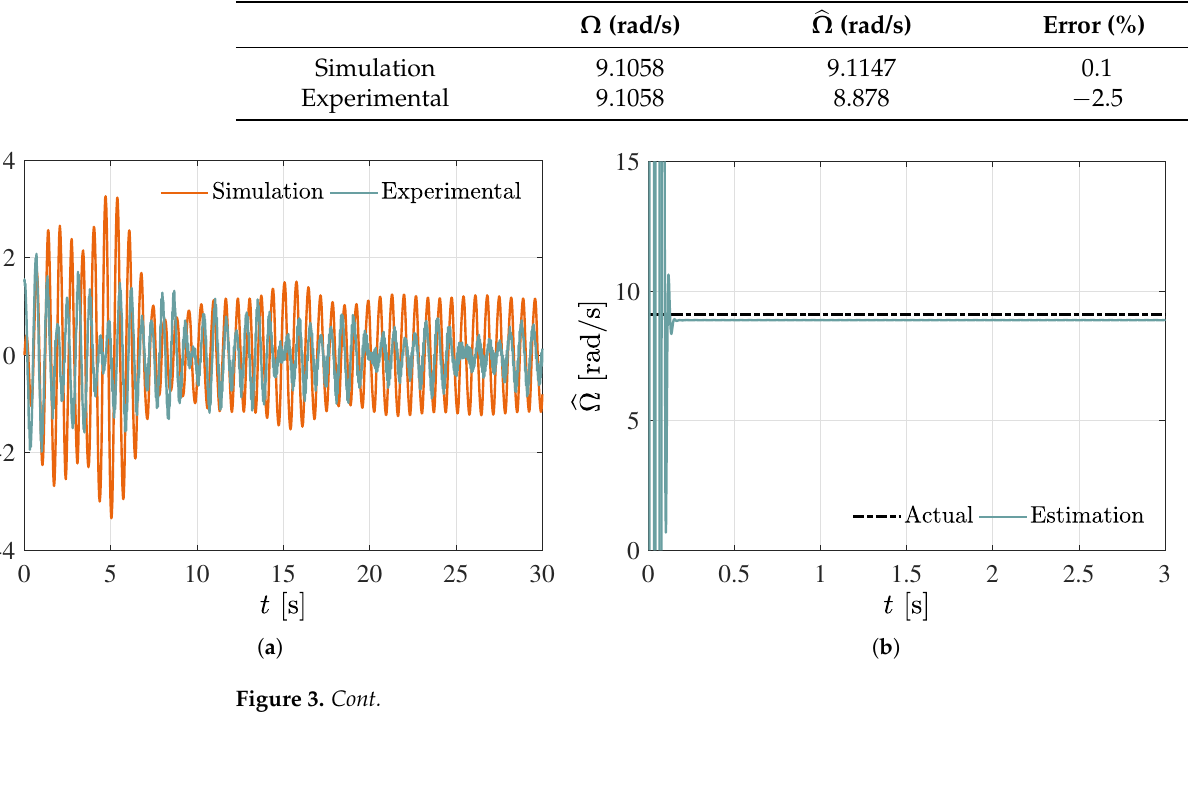
Table 2. Performance of the online frequency estimation.